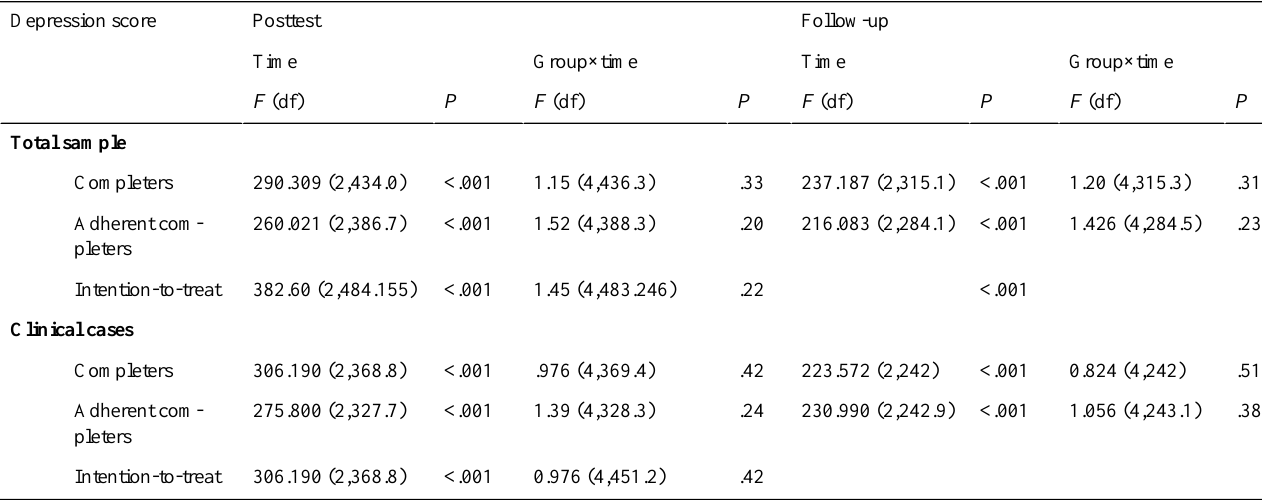
Table 3. Effectiveness of Internet-delivered programs with depression score (CES-D) as dependent variable. Follow-upPosttestDepression